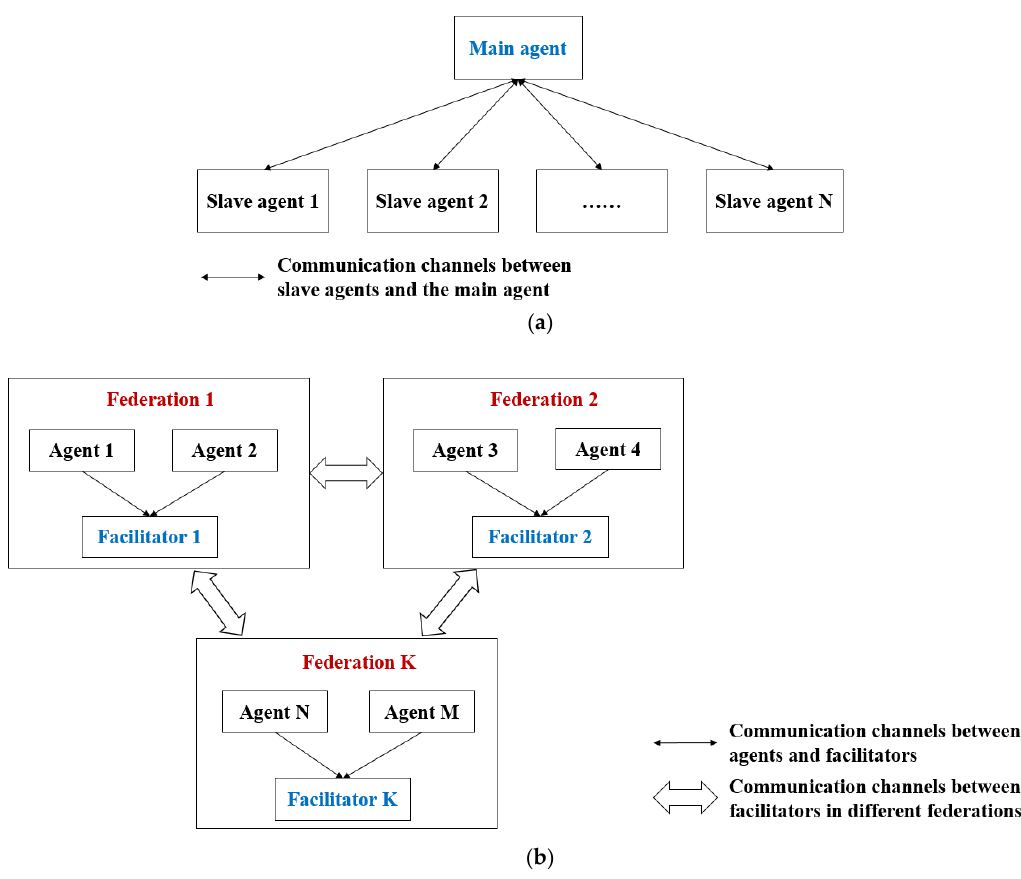
Figure 3. Standard architectures of MAS: ( a ) Absolute-centralized architecture; ( b ) Federal architecture.